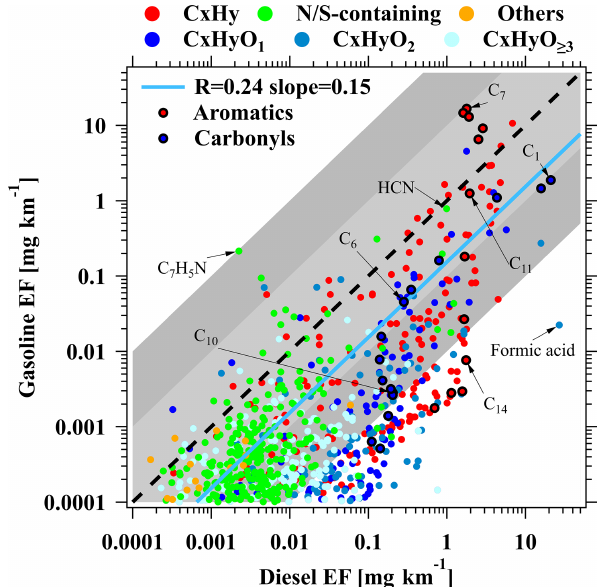
Figure 8. Scatterplot of VOC emission factors between gasoline and diesel vehicles. Each data point indicates a VOC species mea- sured by the PTR-ToF-MS. The blue line is the fitted result for all data points. The black line represents 1/1 ratio, and the shaded ar- eas represent ratios of a factor of 10 and 100.